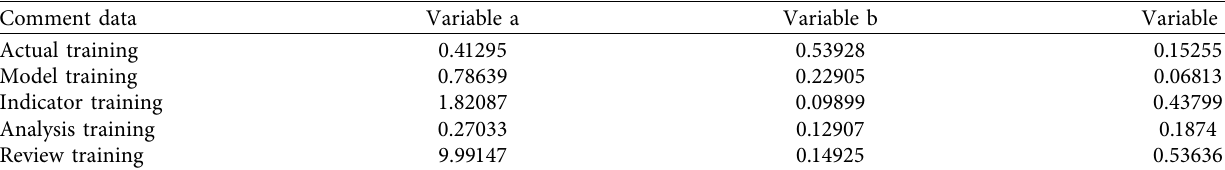
Table 2: Description of neural network smooth